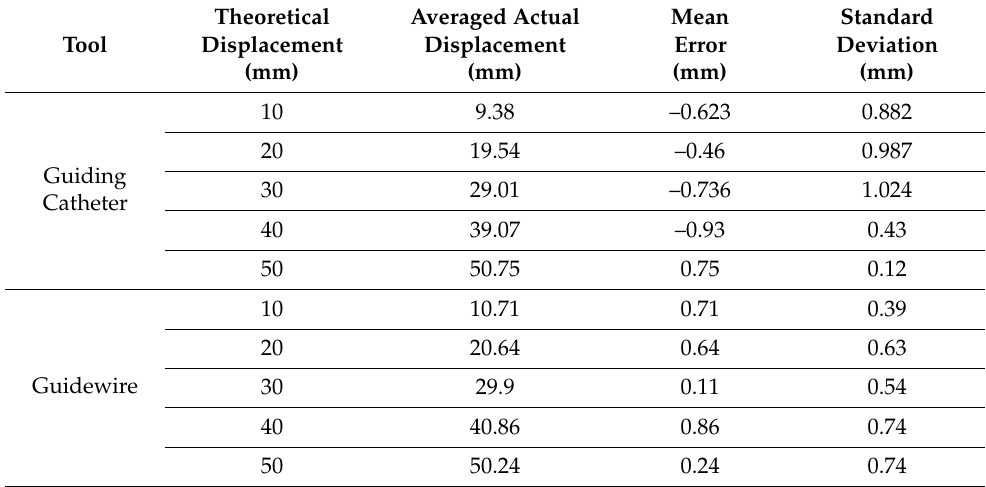
Table 1. Accuracy and precision of translational motion of vascular